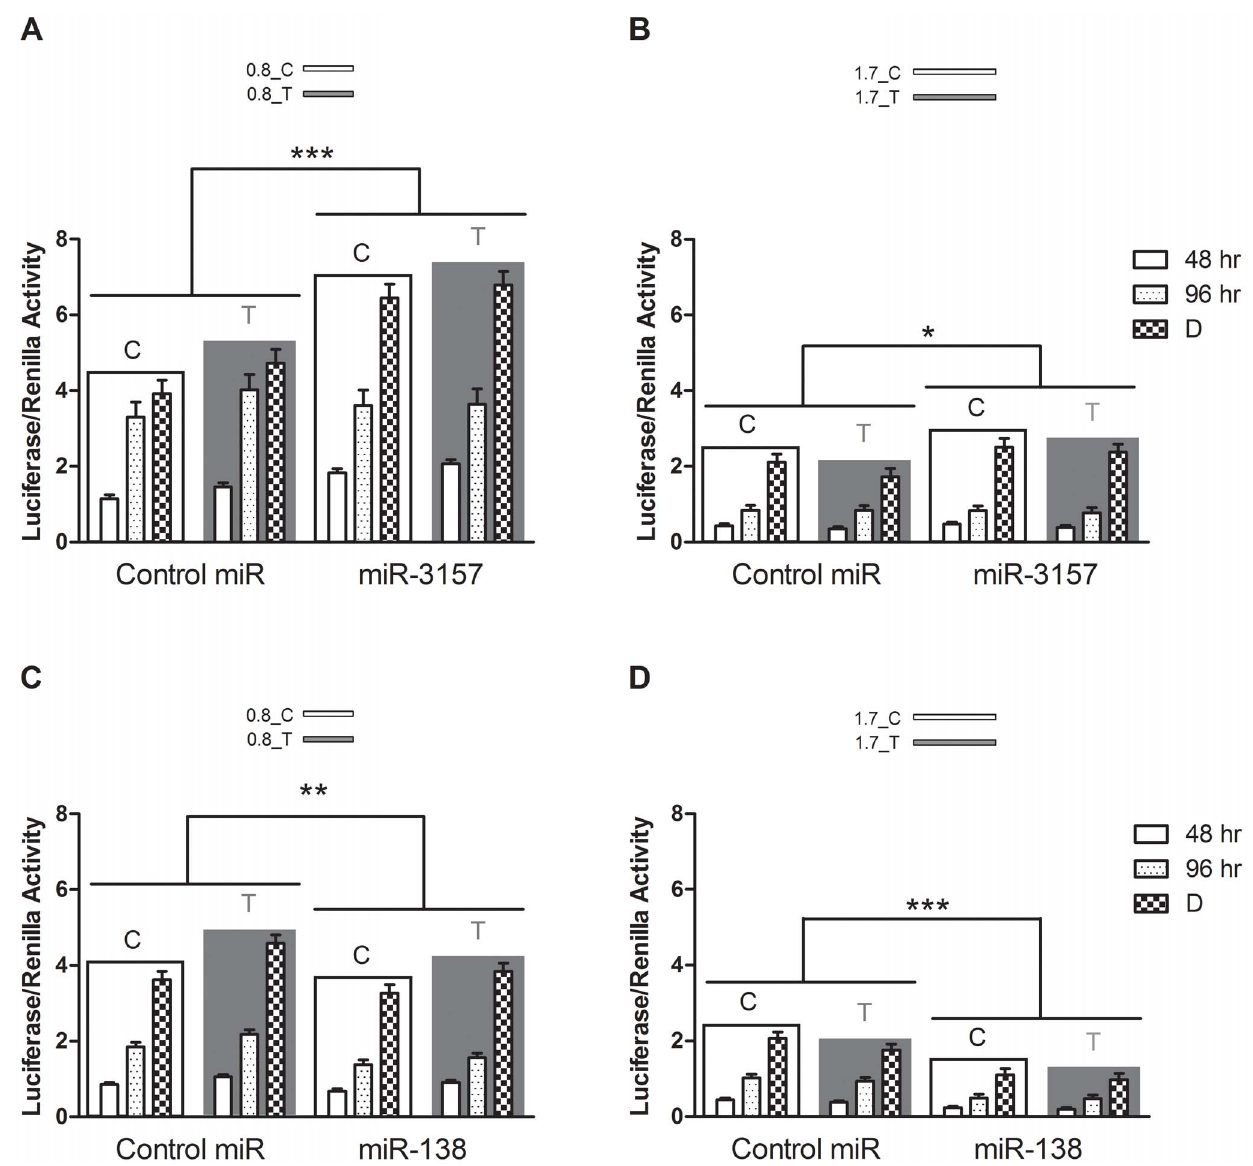
Figure 5. Selected miRNAs modify luciferase expression. (A, B) miR-3157. (C, D) miR-138. Graphs show relative luciferase activity 48, and 98 hr (non-differentiated and differentiated) after co-transfection of pGL3 constructs carrying (A, C) 0.8 kb or (B, D) 1.7 kb inserts, and miRNAs (control miR, miR-3157, and miR-138). Data from different alleles are framed in white (C/major) or grey (T/minor-risk). Asterisks denote differences between the control miR and testing miRNAs (miR-3157 and miR-138). Data are shown as mean + / 2 SEM; * p , 0.05, ** p , 0.01, *** p ,